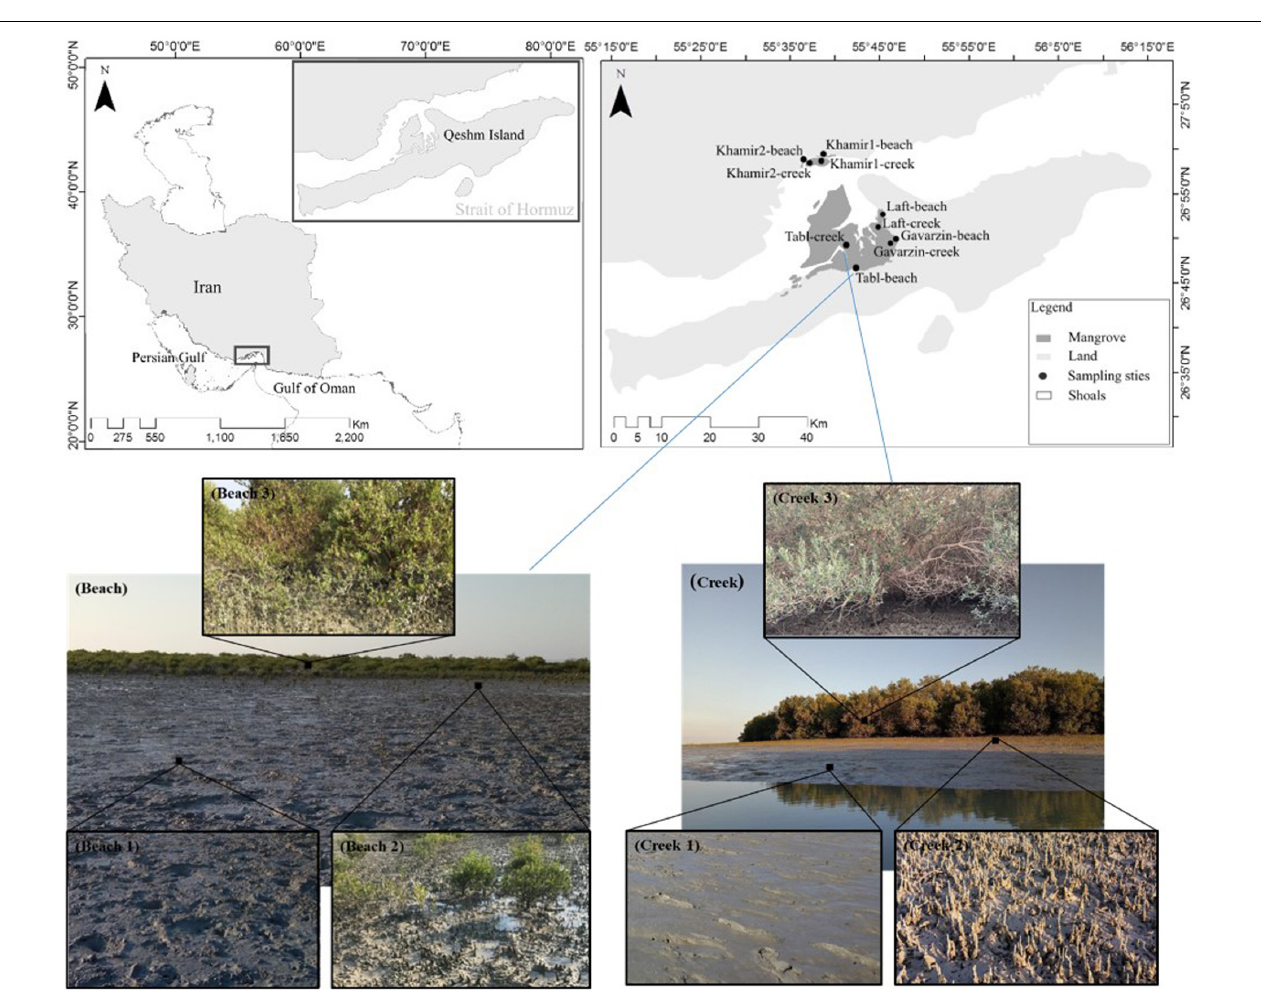
FIGURE 1 | The geographical locations of the sampling areas (upper map) and photos illustrating the different conditions of the Beach habitats and Creek habitats.